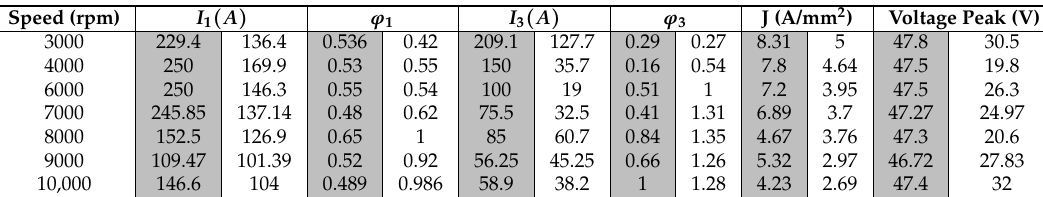
Table 4. Optimal resolution of MTPL strategy at high speed: grey column, MTPL(I); white column, MTPL(II).